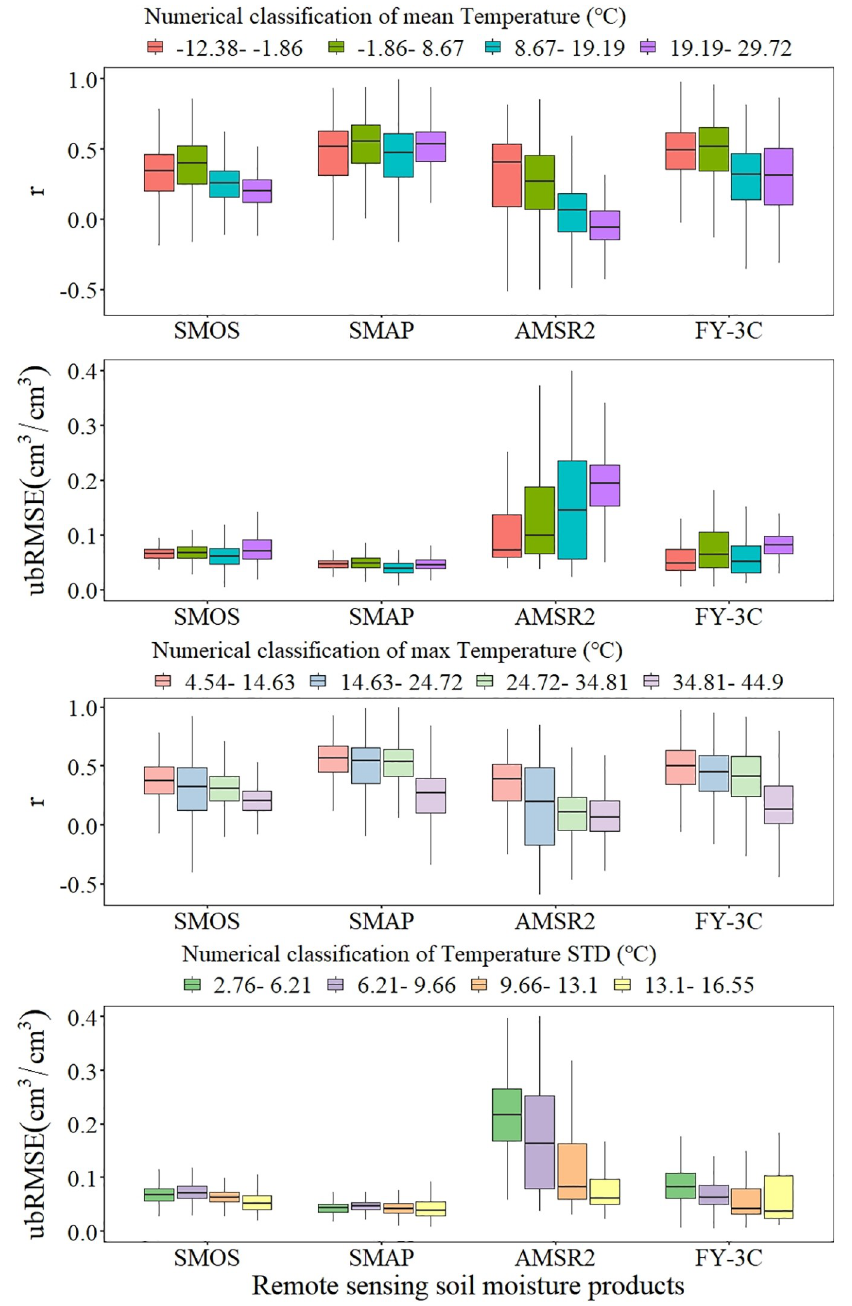
Fig 7. Boxplots of temperature condition for r and